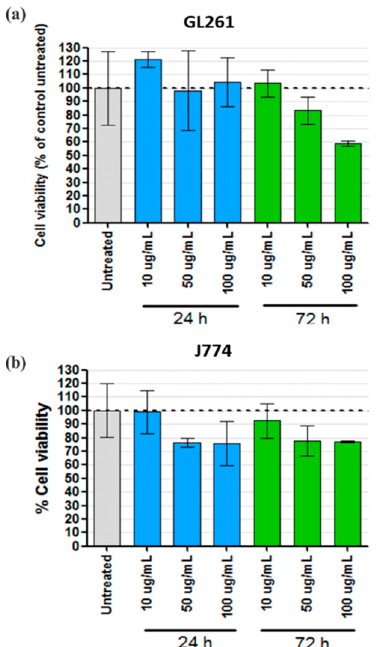
Figure 7. Cell toxicity of SPION-RGO assessed in GL261 glioma and J774 macrophage-like cell lines via modified LDH assay. ( a ) GL261 and ( b ) J774 cells after incubation with different concentrations of SPION-RGO for 24 or 72 h. Results (mean ± SD) are expressed as a percentage of cell viability compared to control untreated cells (two different experiments performed with triplicates).